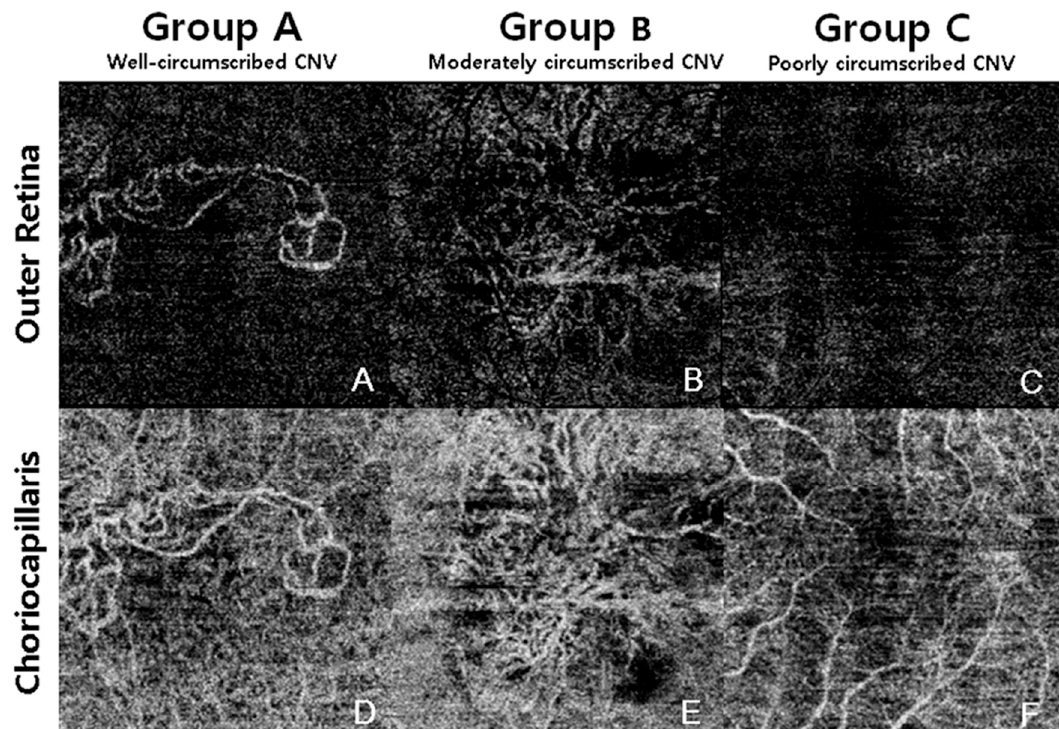
Figure 1. Classification of choroidal neovascularization (CNV) group according to the visualization of CNV in optical coherence tomography angiography. Group A was defined as CNV, of which over 80% of the contour could be demarcated (well-circumscribed vascular complex); Group B, where 50%–80% of the contour could be demarcated (moderately circumscribed vascular complex); and Group C, where less than 50% of the contour could be demarcated (poorly circumscribed vascular complex).